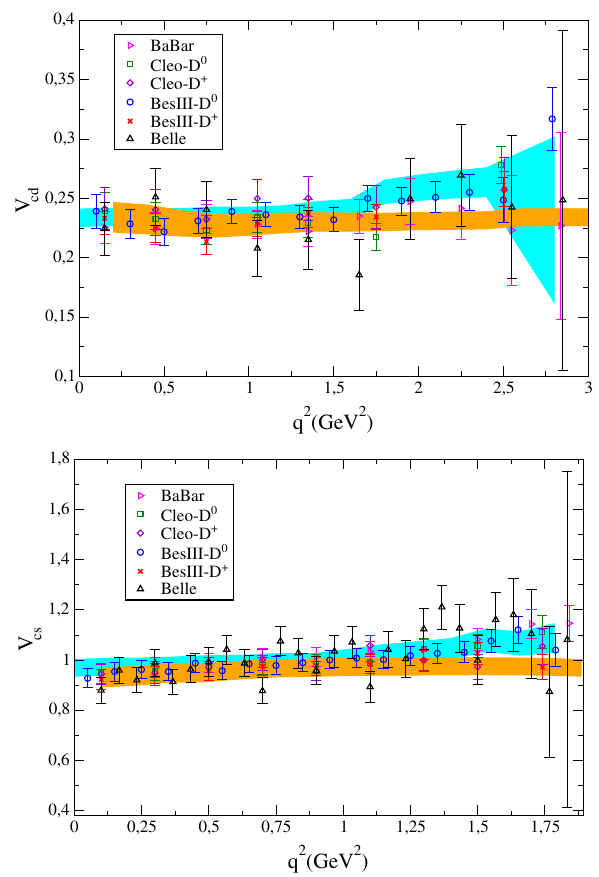
Fig. 1 Values of the CKM matrix elements | V cd | (upper panel) and | V | (lowerpanel)obtainedbycombiningthetheoreticalpredictionsfor cs (cid:10) (cid:11) LAT , based on the vector form factor ) I ( q 2 the phase-space integrals i f DP + ( q 2 ) evaluated on the lattice in Ref. [15], with the experimental data of the D → π and D → K semileptonic differential decay rates (cid:10) (cid:11) EXP , measured by BELLE [4], BABAR [5,6], CLEO [7] and ) (cid:6)(cid:5)( q 2 i BESIII [8,9] collaborations. The bands are described in the